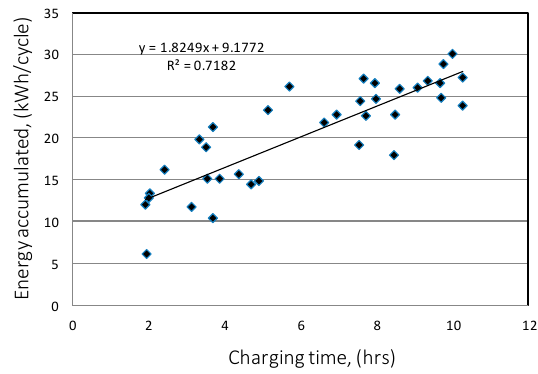
Figure 30. Useful energy as a function of discharge cycle time. Sensors 2020 , 20 , x FOR PEER REVIEW